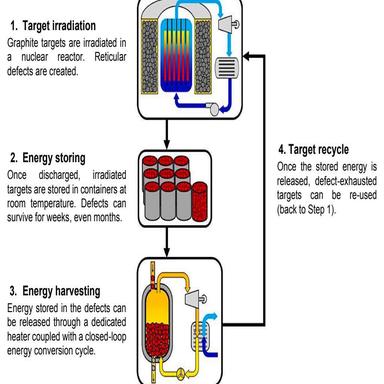
Graphical representation of the proposed integrated energy system. The different steps (from energy storing to energy harvesting) are represented.